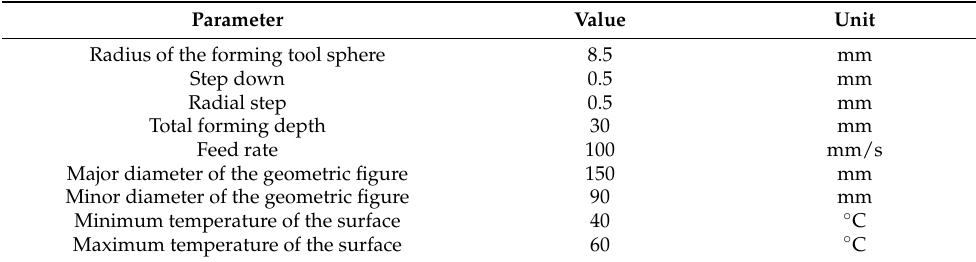
Table 6. Experimental research data for incremental polymer sheet forming.